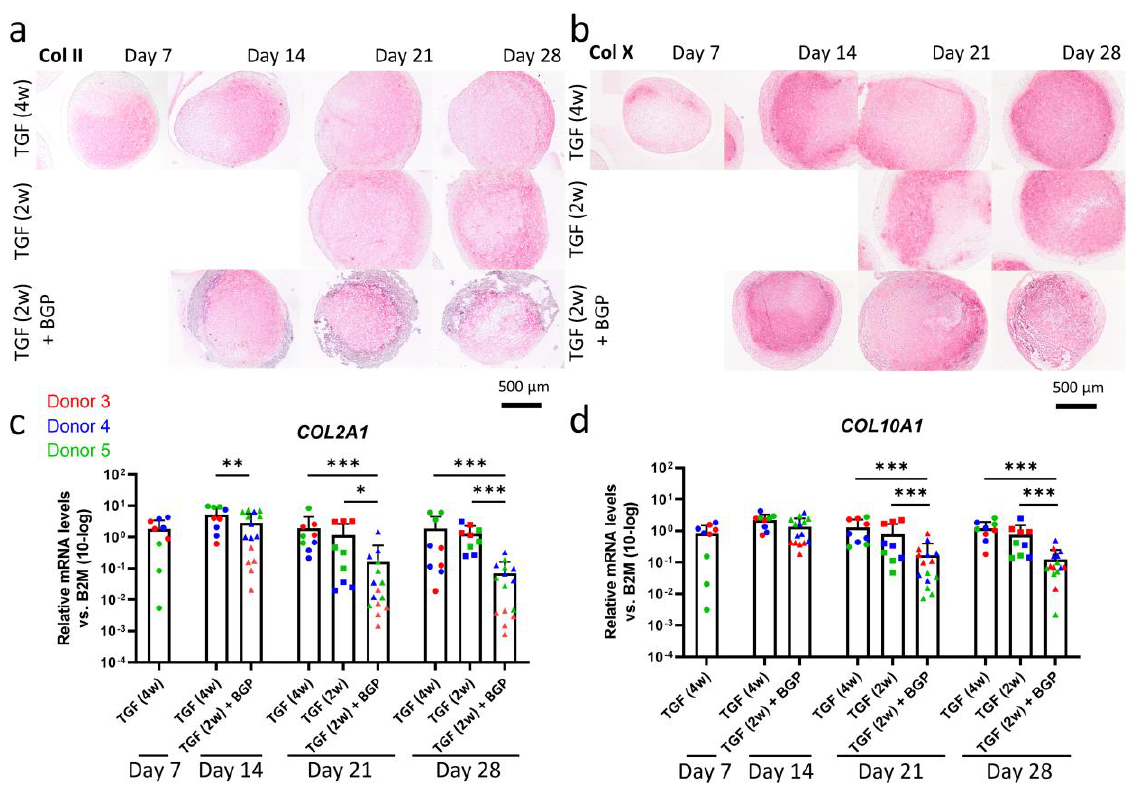
Figure 3. Effect of in vitro mineralisation on collagen expression and accumulation in the pellets. Collagen type II (Col II) ( a ) and collagen type X (Col X) ( b ) immunohistochemical staining of the pellets. Representative images are shown. COL2A1 ( c ) and COL10A1 ( d ) mRNA expression determined by qRT-PCR. B2M was used as the housekeeper gene. Data are presented as average ± SD (N = 3 hMSC donors). * 0.01< p < 0.05, ** 0.01< p < 0.001, *** p < 0.001.